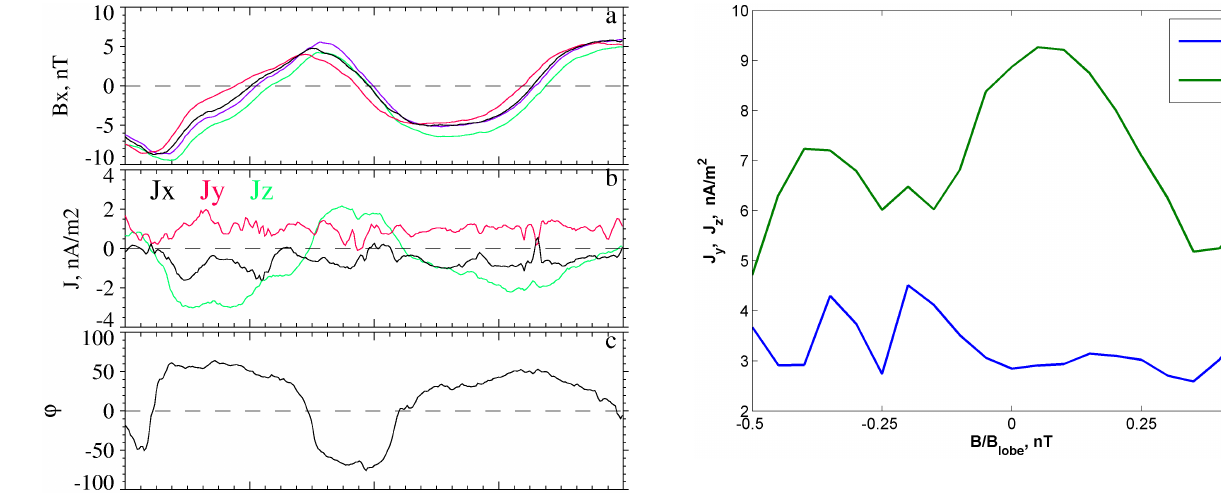
Fig. 8. Average current density profiles for 16 sheets from the Runov et al. (2006) dataset (see text for